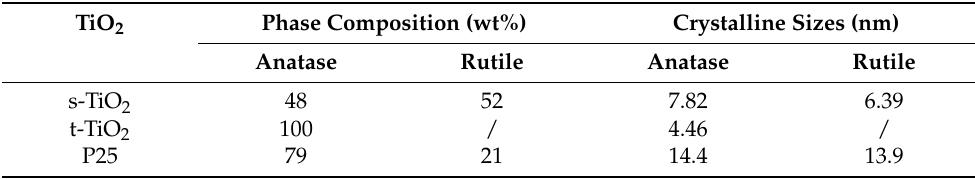
Table 1. Phase component and specific surface areas of s-TiO 2 , t-TiO 2 , and P25.